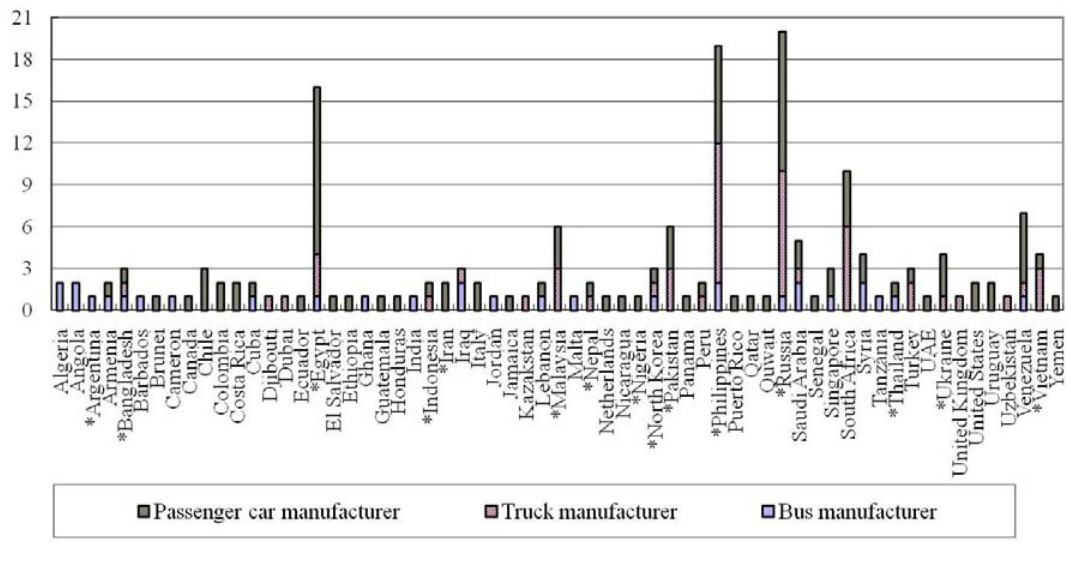
Figure 2. Overseas expansion sites (partial expansion included) of independent manufacturers—number of Foreign-producing manufacturers by country (unit: